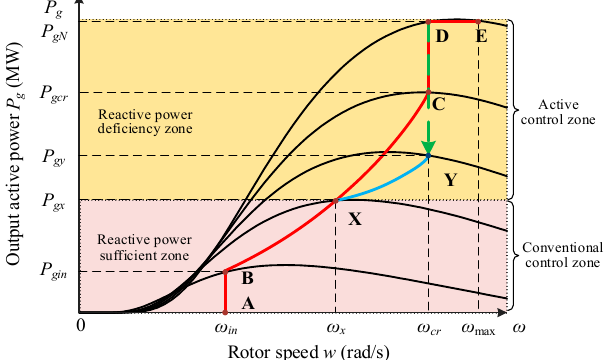
Figure 5. The power variation characteristics of DFIG with the active ω - β coordinate control strategy based on the LRP–RPCD operation curve.